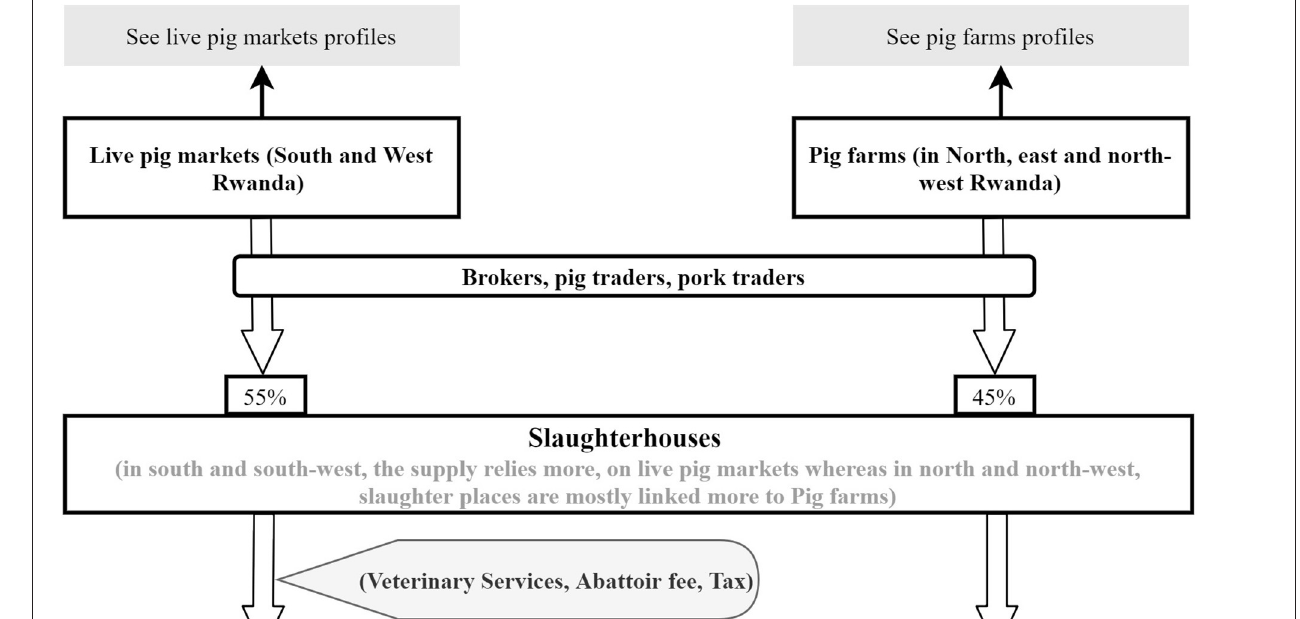
restaurants for slaughter. At farm level, slaughter activities